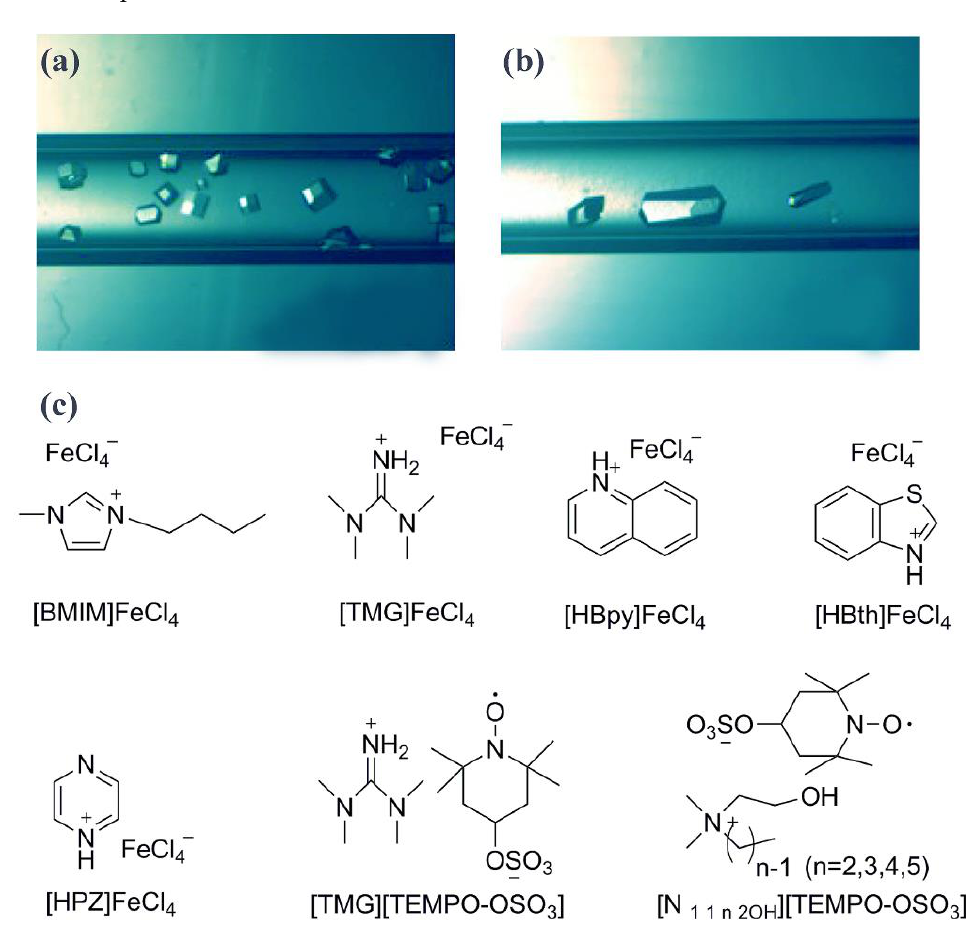
Figure 2. Crystals of lysozyme ( a ) without a magnetic field and ( b ) with a 16.5 T magnetic field [31]; ( c ) the structures of main MILs.